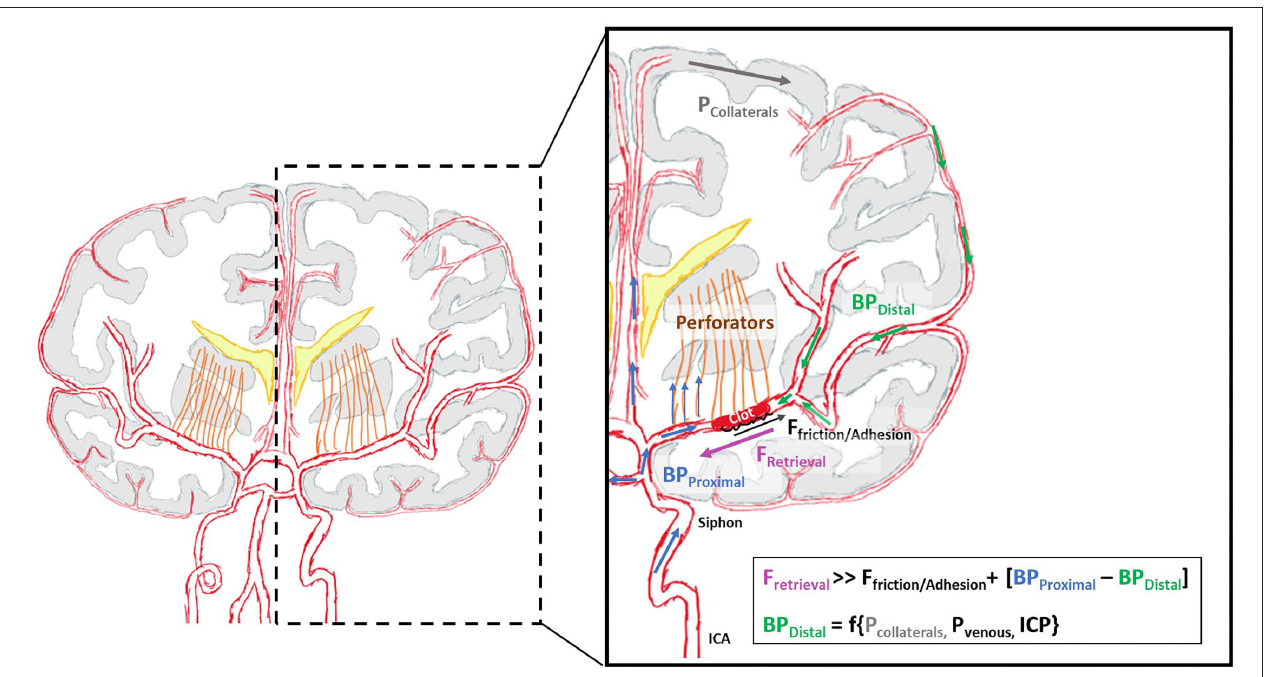
FIGURE 2 | Schematic of forces acting on the clot in-vivo during